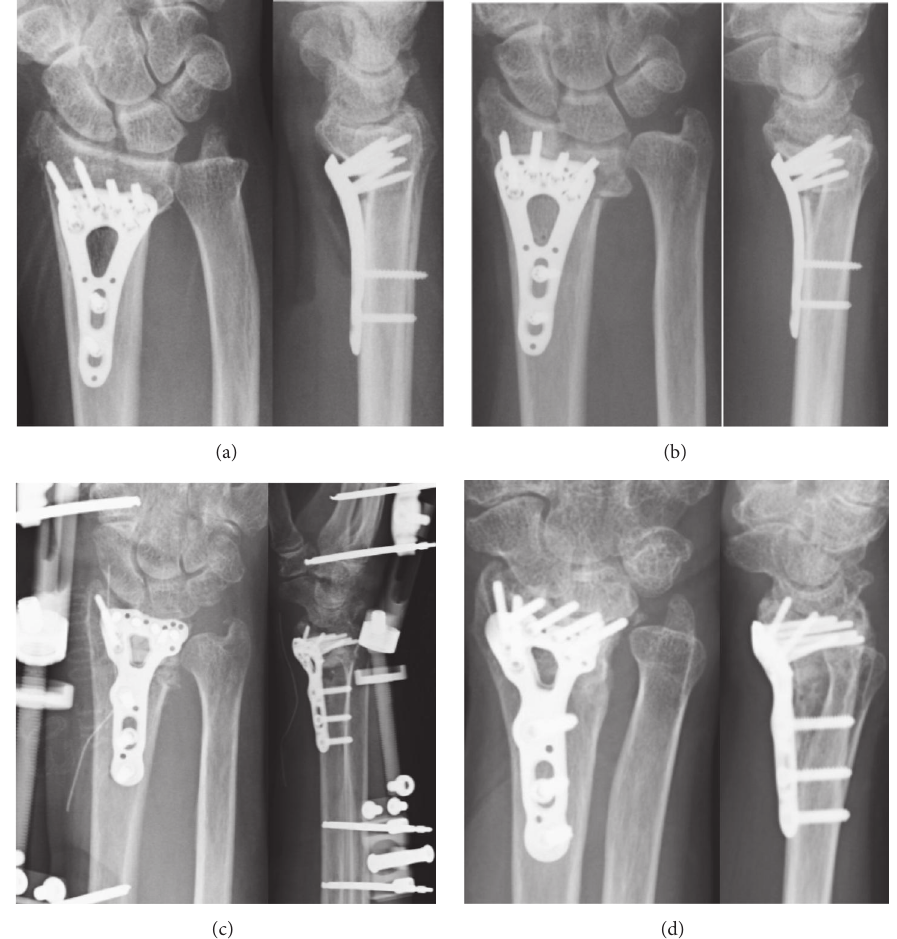
Figure 4: Plain radiographs of Patient 2. (a) Immediately after the first surgery. (b) Six weeks after the first surgery; redisplacement is seen. (c) Immediately after reoperation. (d) Nine months after reoperation; bone union was achieved without